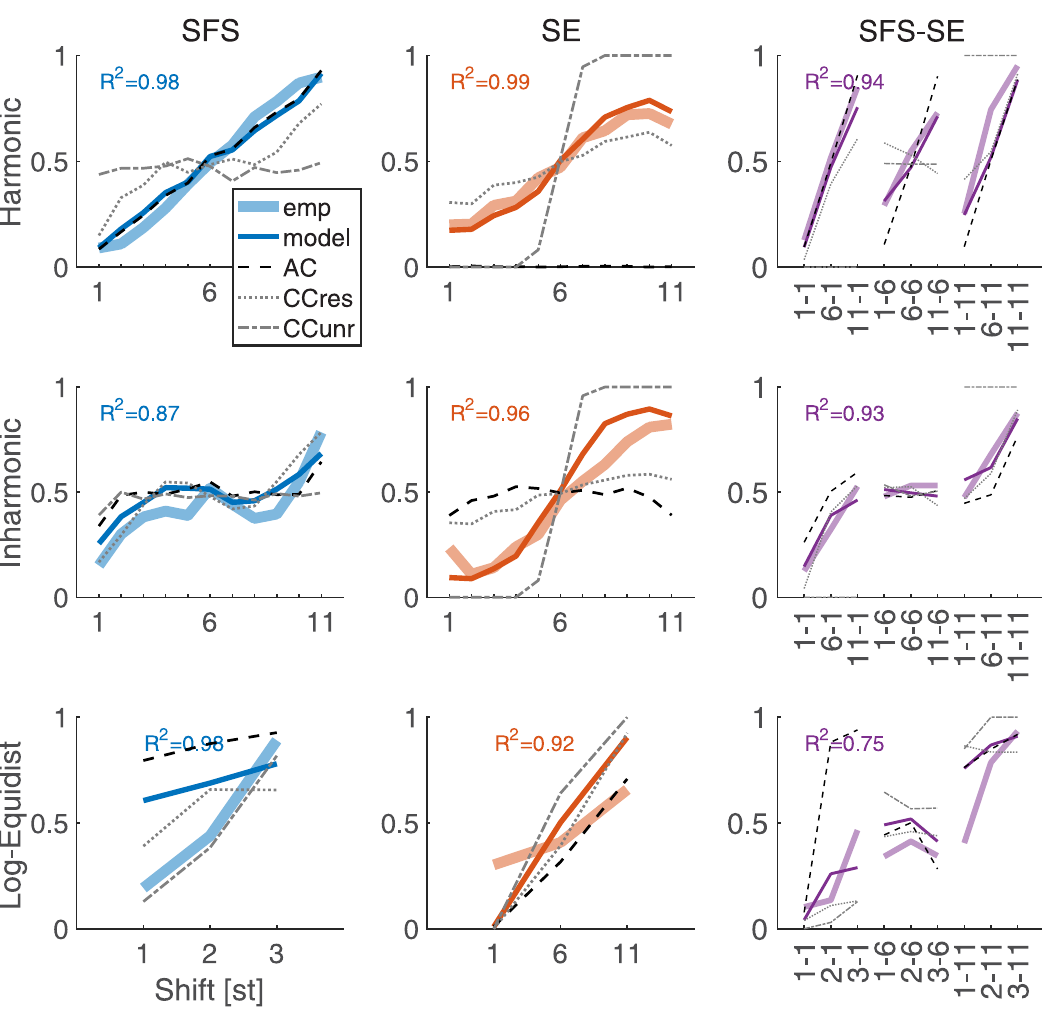
Fig 6. Model results and human listeners across all experiments. The y-axis shows the proportion of “down” responses. The x- axis indicate shift size; for two-dimensional shifts, pairs indicate shifts along the SFS and SE dimension, respectively. The rows index the properties of the fine structure (harmonic, inharmonic (Exps. 1&2) and log-equidistant (Exp. 3). The columns index the shift type, one-dimensional SFS or SE, and two-dimensional SFS-SE with average data from human listeners and the model plotted in thick and thin colored lines, respectively. Raw predictions from the AC, CCres, and CCunres cues as indicated in the legend. R 2 values for correlation between average model and empirical data (omitted for log-equidistant SFS and SE shifts of Exp. 3 due to insufficient number of shifts). R 2 values for raw cues are provided in Table E in S1